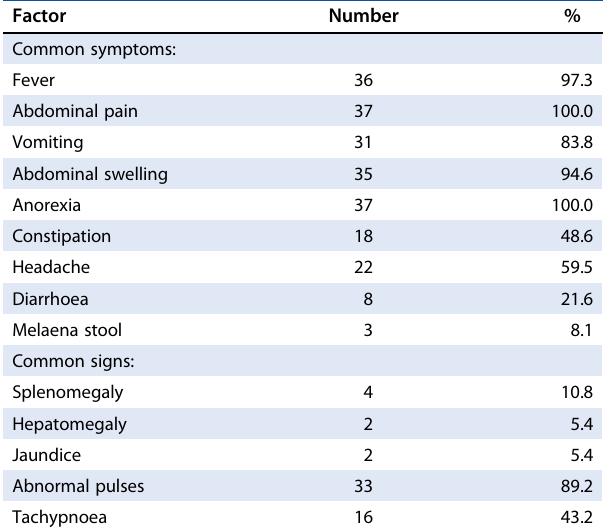
Table 2: Common symptoms and signs associated with typhoid ileal perforation reported by the subjects Factor Number % Common